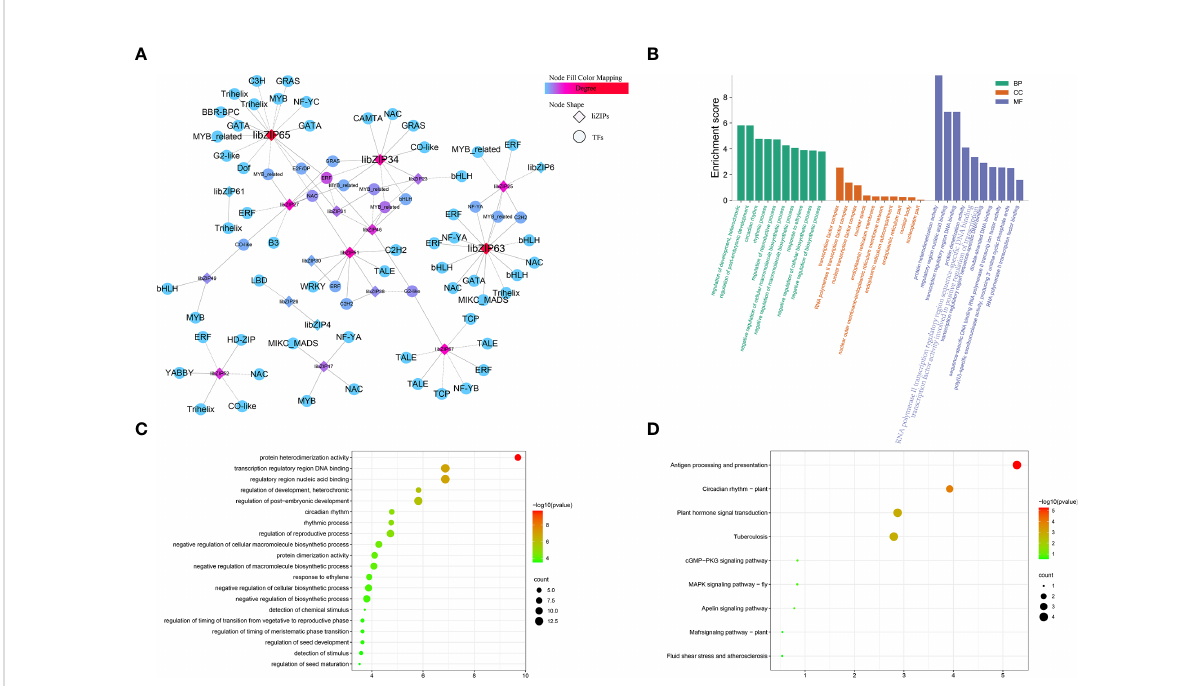
FIGURE 6 I. indigotica IibZIP gene co-expression network, and GO term and KEGG pathway enrichment analysis. (A) Co-expression network of IibZIP genes constructed based on the transcriptome of I. indigotica leaves under salt stress. Diamonds indicate the IibZIP genes and circles indicate other transcription factors. The color shade indicates the number of relevant genes. (B) GO term annotations of IibZIP genes and co-expressed transcription factors. BP, biological processes; CC, cellular components; MF, molecular functions. (C) GO term enrichment analysis of IibZIP genes and co-expressed transcription factors. (D) KEGG pathway enrichment analysis of IibZIP genes and co-expressed transcription